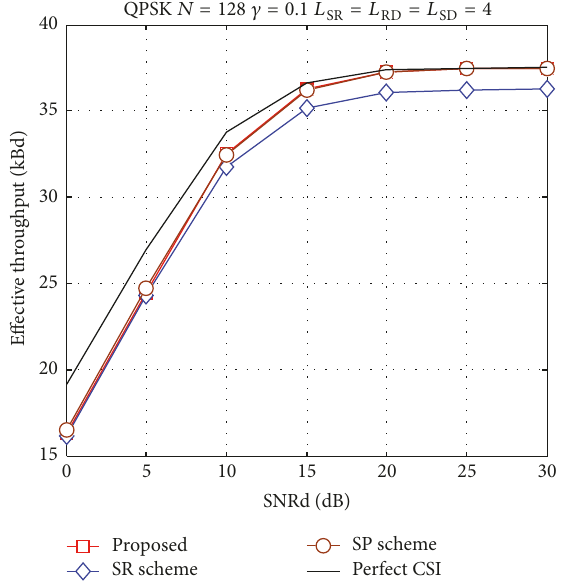
Figure 7: Effective throughput of different